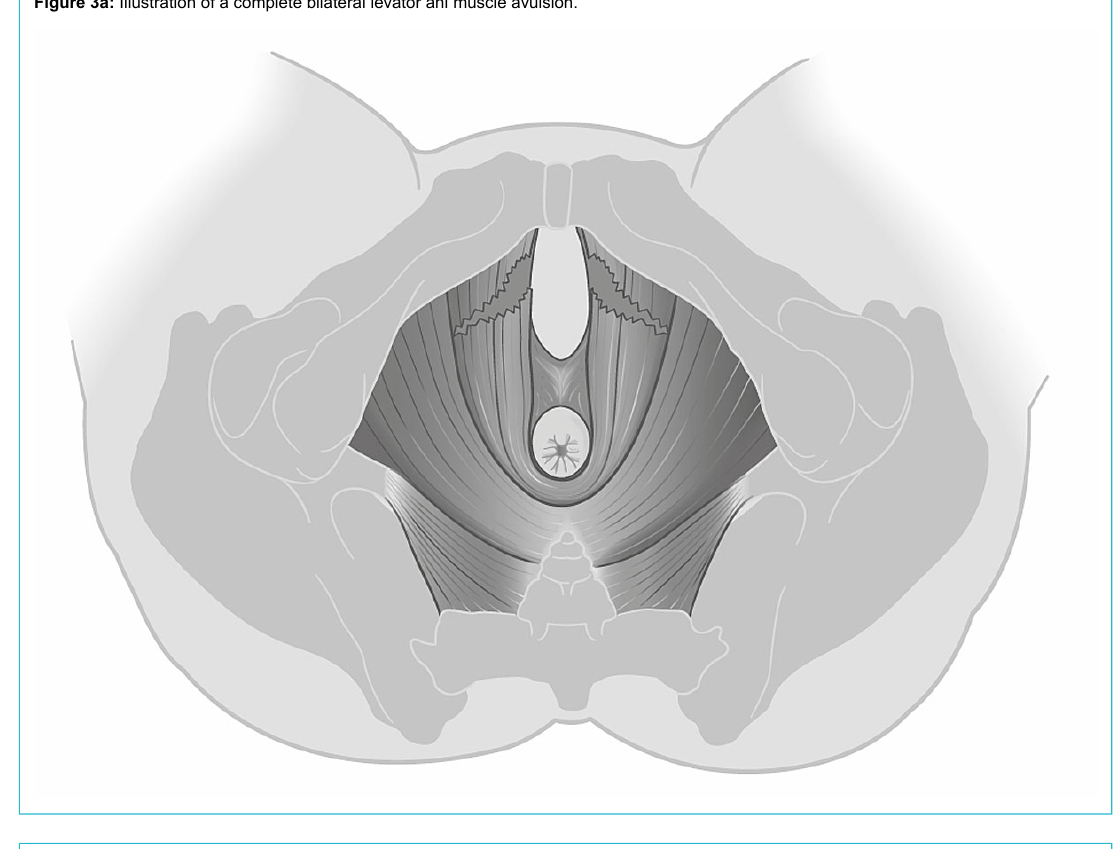
Figure 3a: Illustration of a complete bilateral levator ani muscle avulsion.